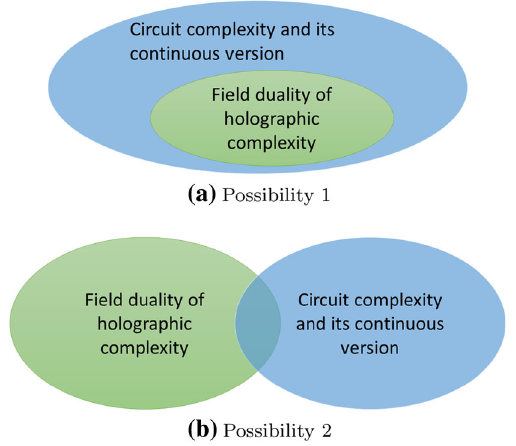
Fig. 2 Aschematicexplanationsforpossiblerelationshipsbetweenthe circuit complexity and the field-theory duals of the holographic com- plexity. a The field theory dual of the holographic complexity belongs to the continuous version of the circuit complexity. b The field theory dual of the holographic complexity and a continuous version of the circuit complexity share some common properties, but, there are still differences too ¯ C sional Lie group) G , the function is invariant under a